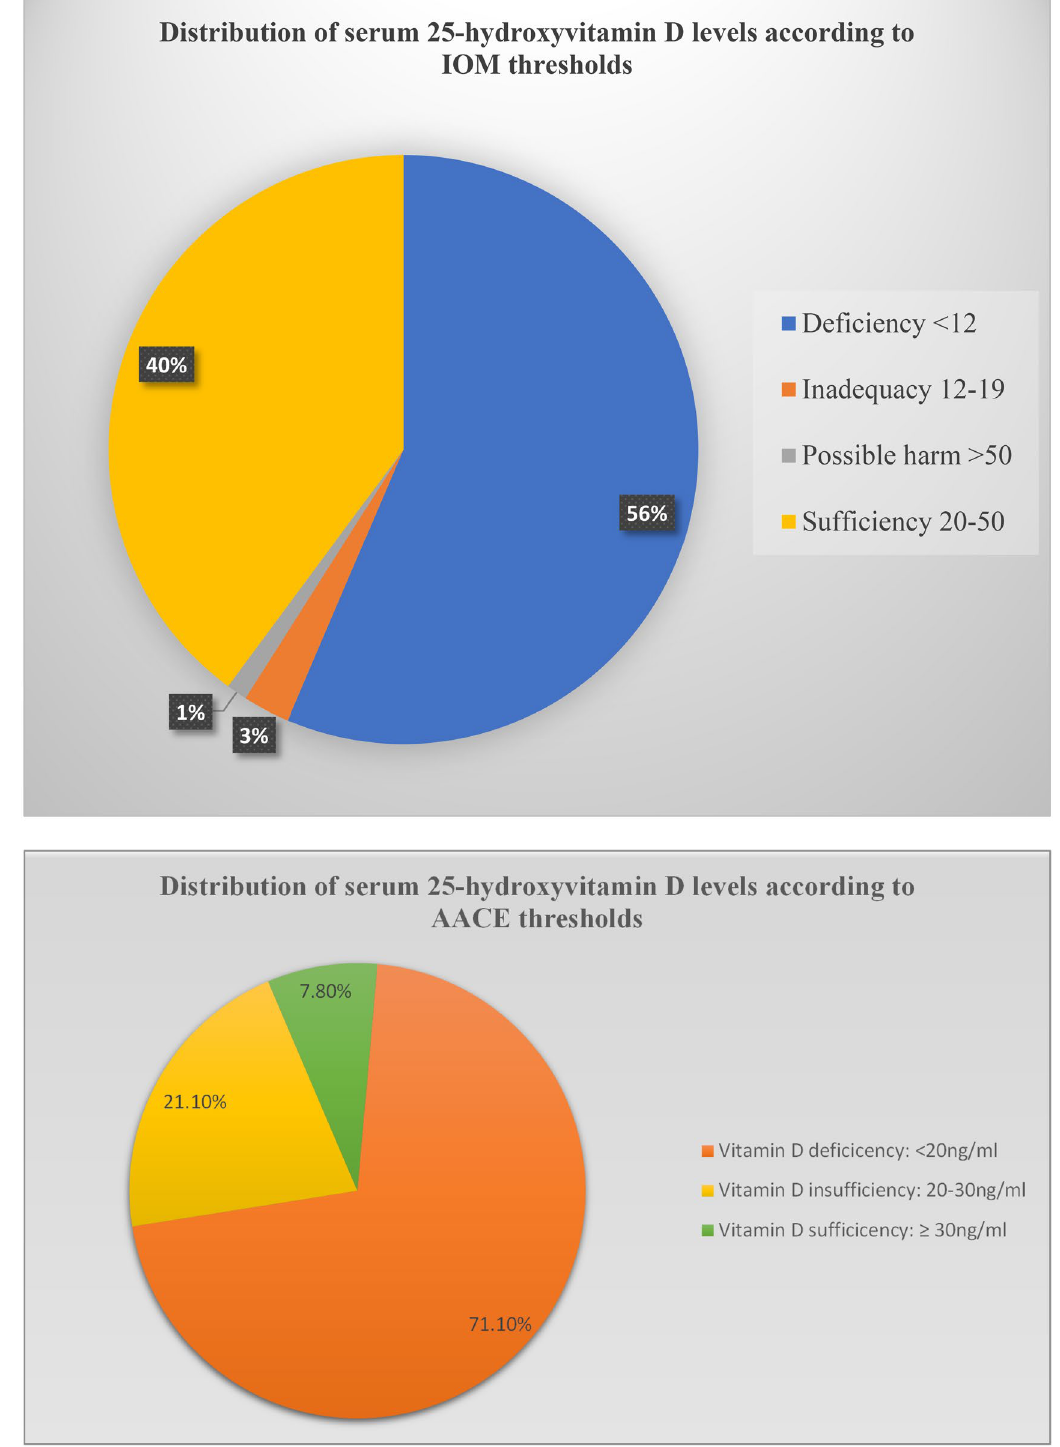
Figure 2. Comparison of distribution of serum 25-hydroxyvitamin D levels according to IOM (Institute Of Medicine) and AACE (American Academy of Clinical Endocrinology)